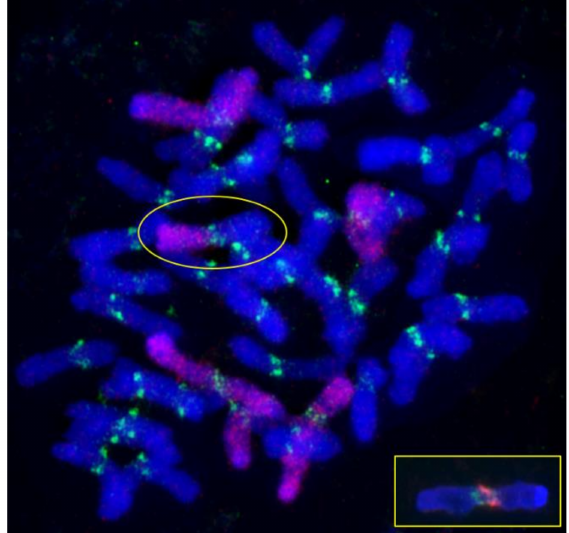
Figure 7. Chromosome sets of the same plant progeny of subgroup 1b with a 1BL.1RL translocation (2 n = 42) (shown with an arrow): ( a ) C-banding; ( b ) GISH; rye chromosomes are labeled red and centromeres with green.